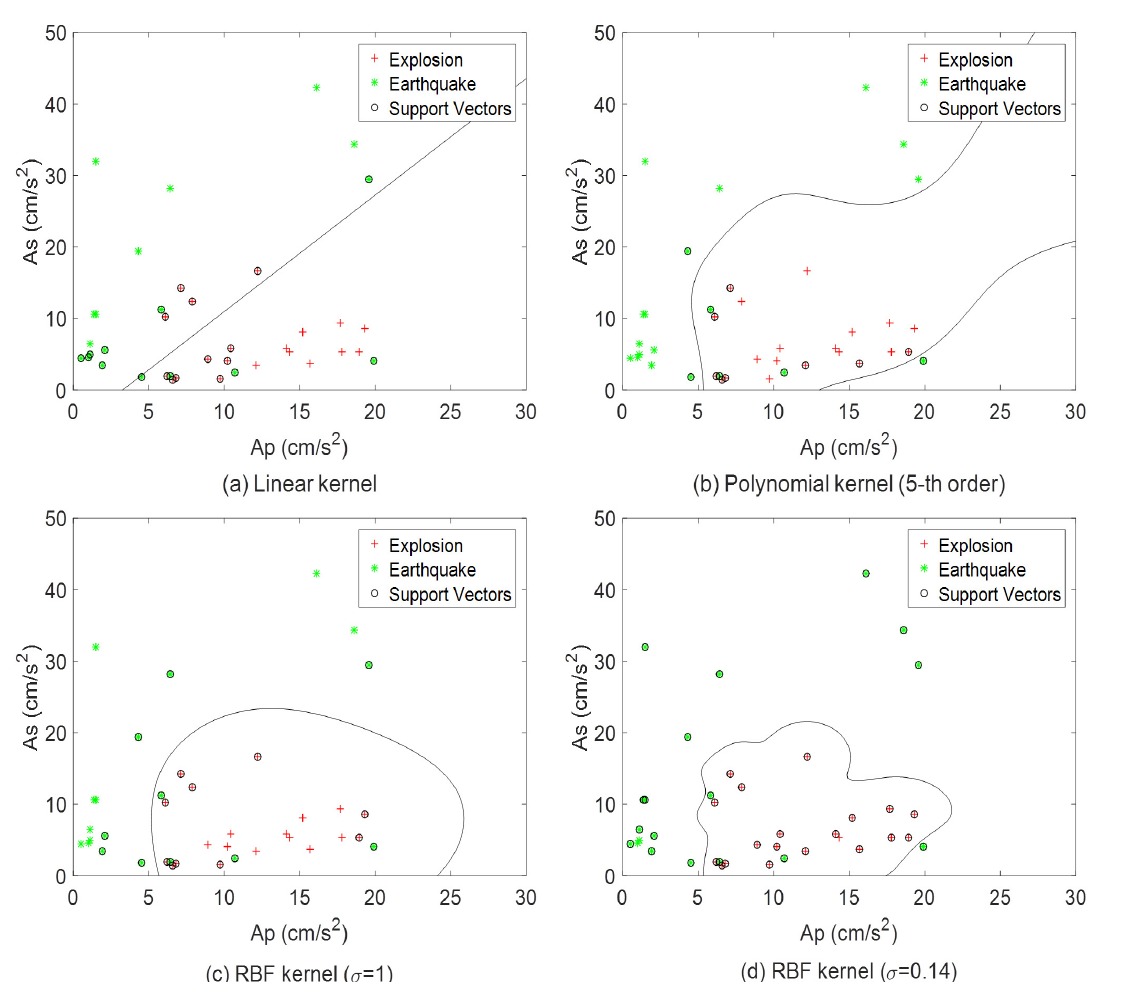
Figure 6. SVM classifier with different kernel